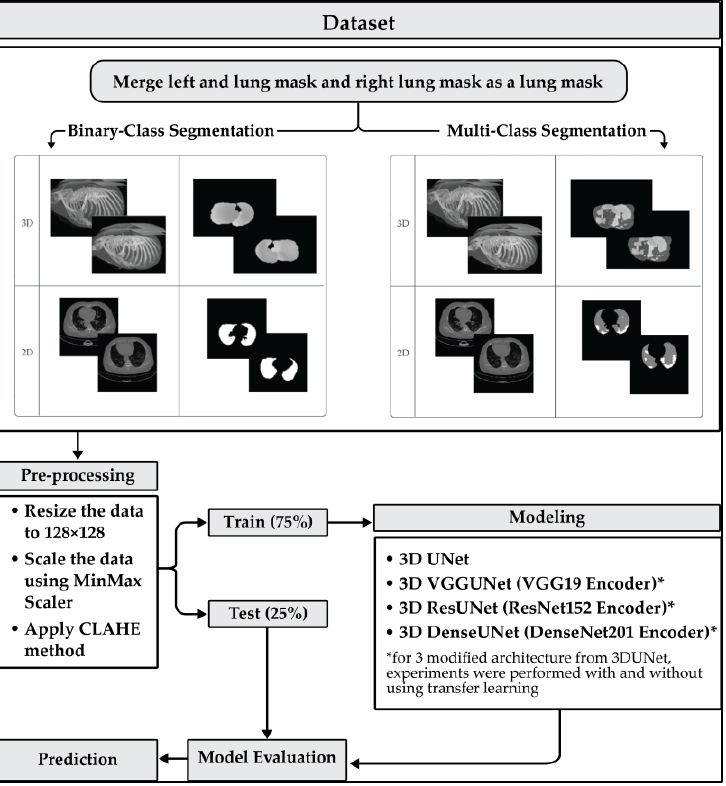
Figure 3. The modeling schemes.